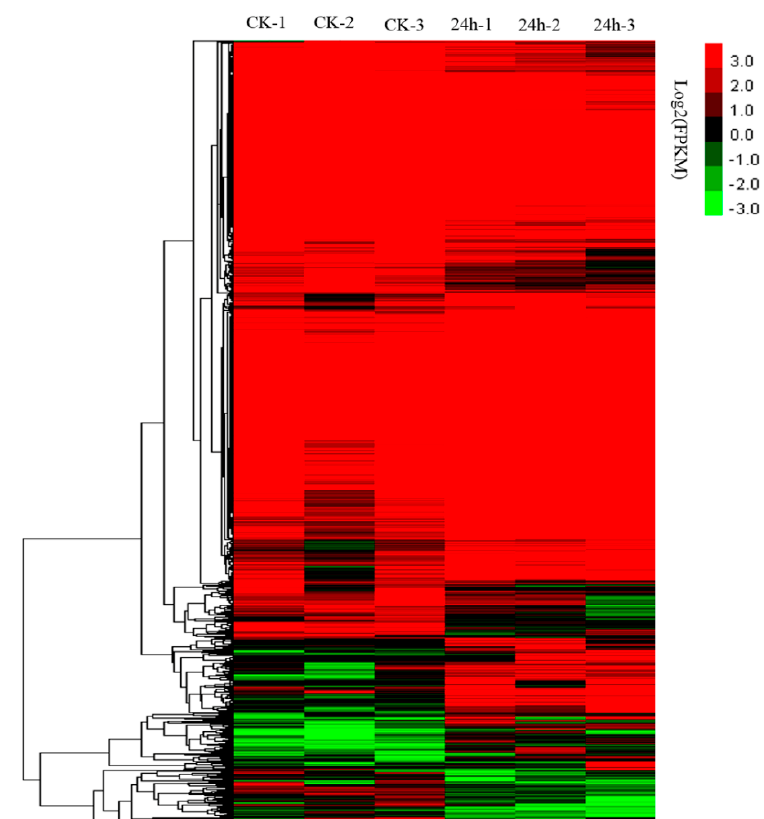
Figure 3. Hierarchical clustering of differential expression profiles for 1641 genes between the 24 hpi and ck watermelon leaf libraries (false discovery rate (FDR) ≥ 0.05 and absolute value of the log2 ratio > 1).